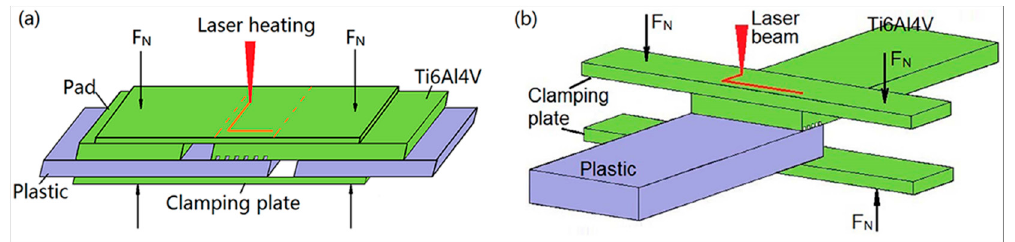
Figure 1. Schematic diagrams of laser joining process. ( a ) Conventional direct laser joining process; ( b ) the modified laser joining process.